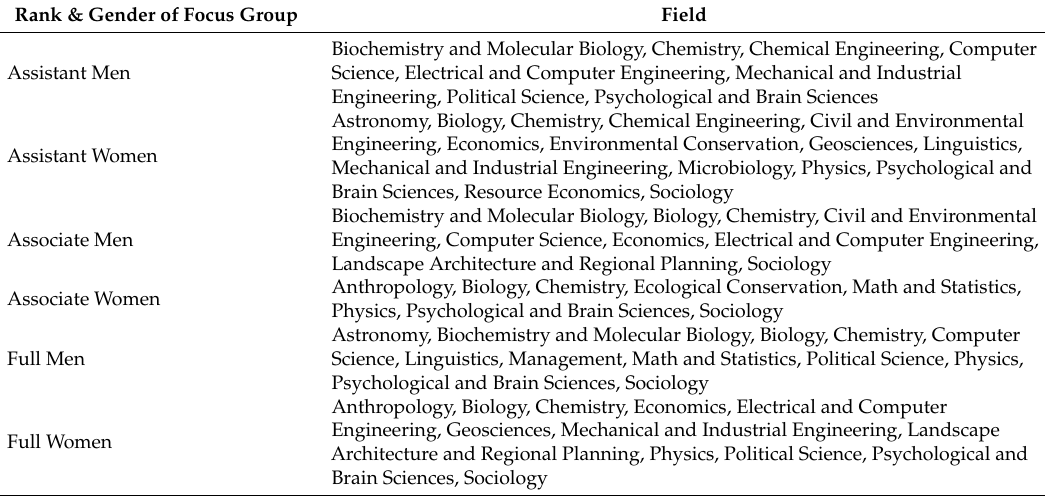
Table 1. STEM Fields Represented in Focus